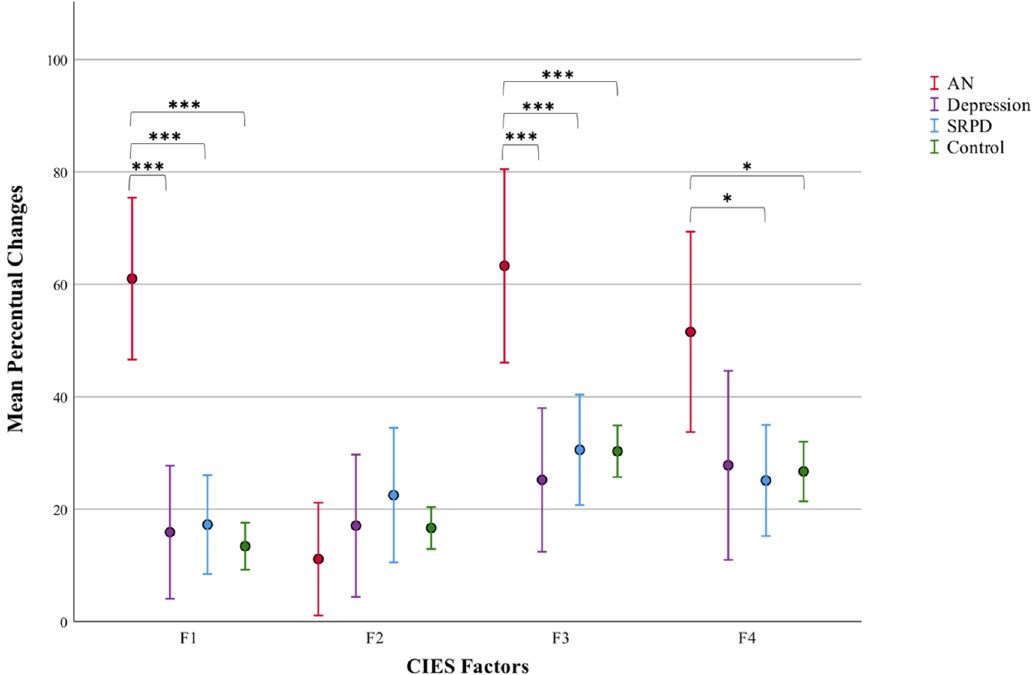
Figure 1. Percentual changes of CIES factors pre vs. during lockdown by group with 95% confidence interval error bars; results of ANOVAs with pairwise post hoc Bonferroni corrections for number of tests (* p < 0.05, *** p < 0.001) (F1, restrictive eating; F2, overeating; F3, anxiety and depressive symptoms; F4, emotion-regulation problems).